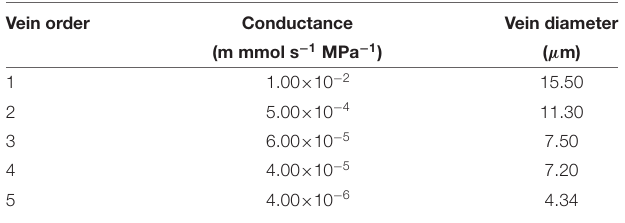
TABLE 3 | Xylem vein conductivities; phloem conductivities are a factor of 3/100 lower. Vein order